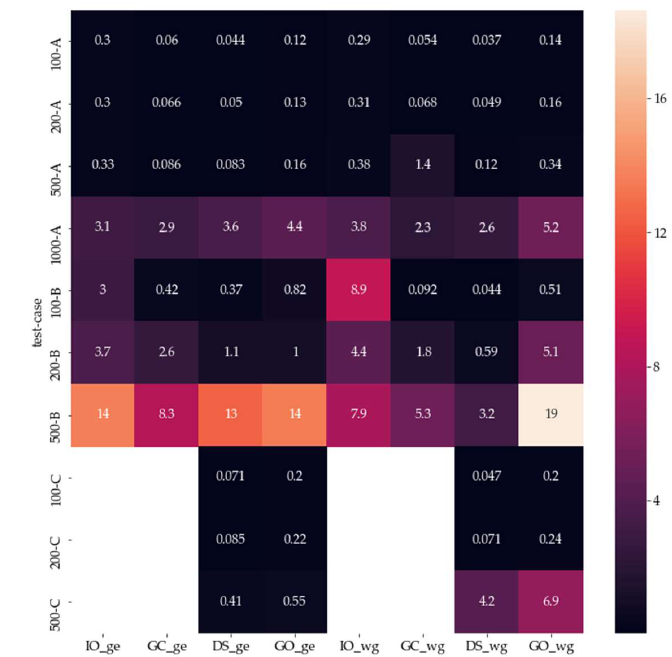
Figure 11. Average response time for different requests (IO, GC, DS, GO) and WSGI servers (ge = gevent and wg = mod_wsgi ) versus different test cases characterized by different concurrent users (100, 200, 500, 1000) and monitoring networks (A = small size, B = large number of observations, C = large number of sensors).